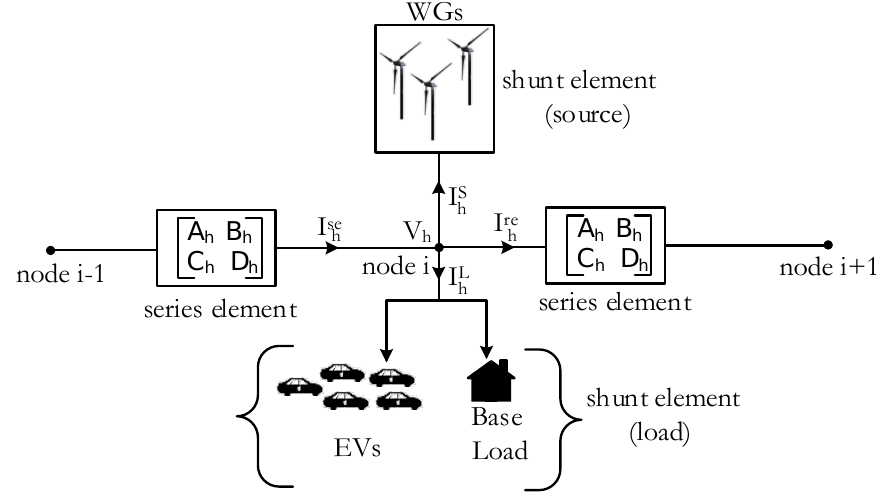
Figure 2. Circuit connection showing the branch currents and nodal voltages used for modeling the harmonic power